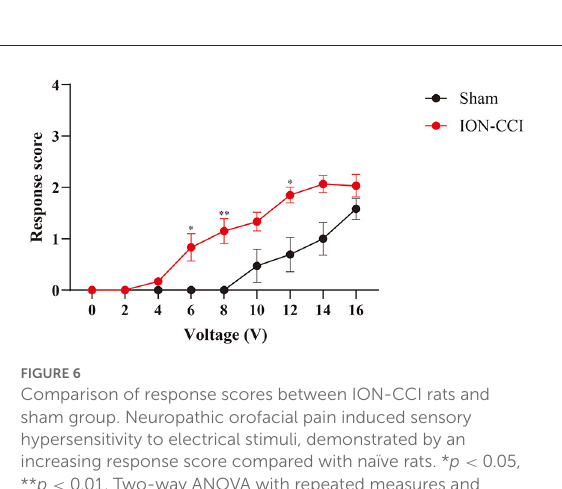
FIGURE6 Comparison of response scores between ION-CCI rats and sham group. Neuropathic orofacial pain induced sensory hypersensitivity to electrical stimuli, demonstrated by an increasing response score compared with naïve rats. * p < 0.05, ** p < 0.01, Two-way ANOVA with repeated measures and Bonferroni’s